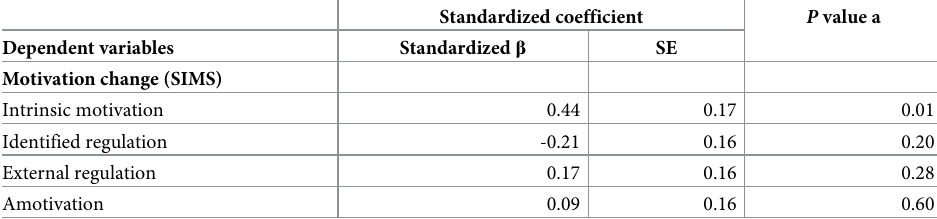
Table 3. Multiple linear regression analysis for associations of motivational enhancement smartphone application with motivation